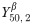
Family Y50,2β with β = 1, 2, …, 101.CEN, MCEN, ACC* and MCC* as function of β.